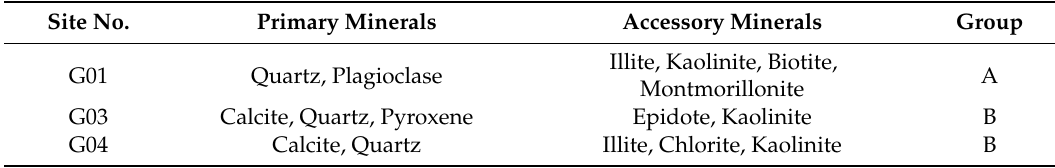
Table 1. Mineral composition of the samples derived from XRD